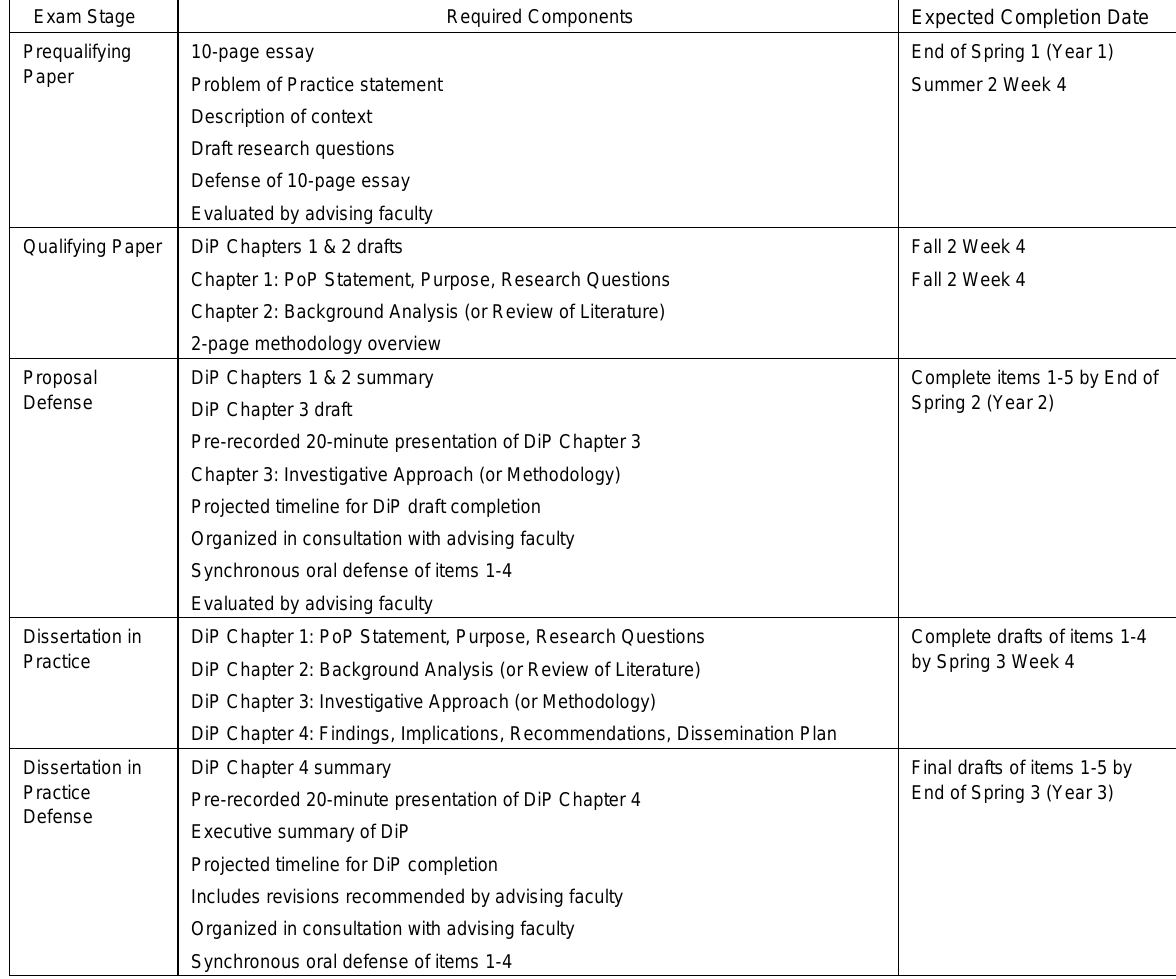
Table 2. Overview of Exam Stages and Dissertation in Practice Chapters Exam Stage Required